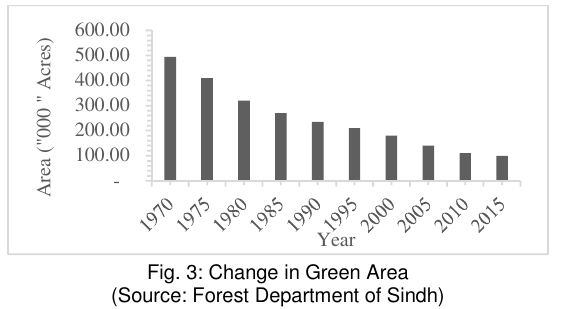
Table 4: Average Annual Consumption of Commercial Buildings (Source: